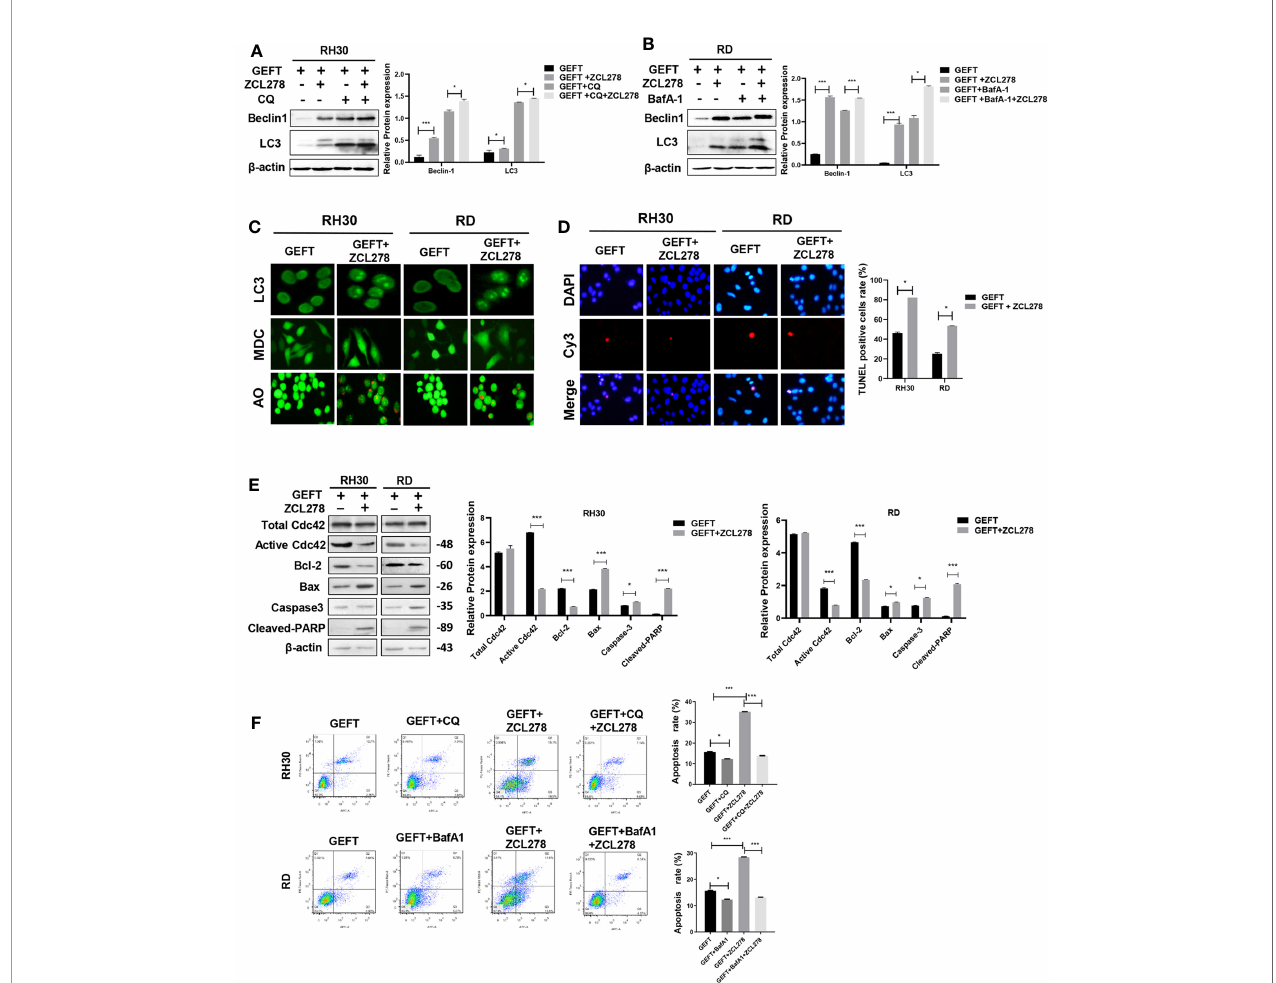
FIGURE 4 | GEFT can inhibit autophagy and apoptosis in RMS cells via Cdc42. (A) Western blotting was used to detect the expression of Beclin1 and LC3 protein in RH30 cells transfected with GEFT, GEFT+ZCL278, GEFT+CQ, and GEFT+CQ+ZCL278. (B) Western blotting was used to detect the expression of Beclin1 and LC3 protein in RD cells transfected with GEFT, GEFT+ZCL278, GEFT+BafA-1, and GEFT+BafA-1+ZCL278. (C) The representative images of RH30 and RD cells transfected with GEFT and GEFT+ZCL278 were detected by immuno fl uorescence, MDC and AO staining. (D) The apoptosis of RH30 and RD cells transfected with GEFT and GEFT+ZCL278 was detected by TUNEL. (E) Western blotting was used to detect the expression of GEFT, Total Cdc42, Active Cdc42, Bax, Bcl-2, Caspase-3, and Cleaved-PARP protein in RH30 and RD cells transfected with GEFT and GEFT+ZCL278. (F) Flow cytometry was used to detect the apoptosis of RH30 cells and GEFT-transfected RH30 cells in GEFT, GEFT+CQ, GEFT+ZCL278 and GEFT+ZCL278+CQ groups. Flow cytometry was used to detect the apoptosis of RD cells and GEFT-transfected RD cells in GEFT, GEFT+BafA-1, GEFT+ZCL278 and GEFT+ZCL278+BafA-1 groups. *** P < 0.001, * P <